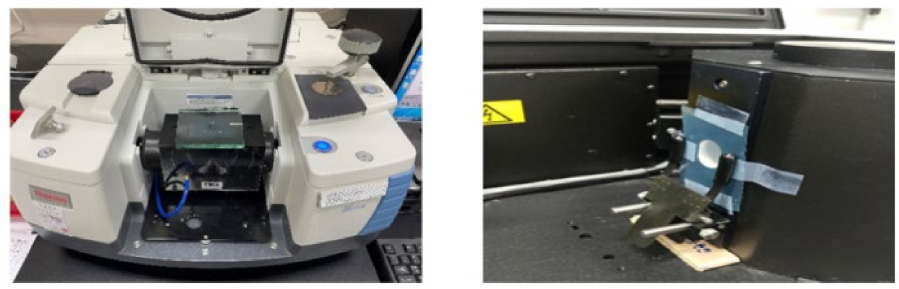
Figure 5. Fourier transform infrared spectrometer